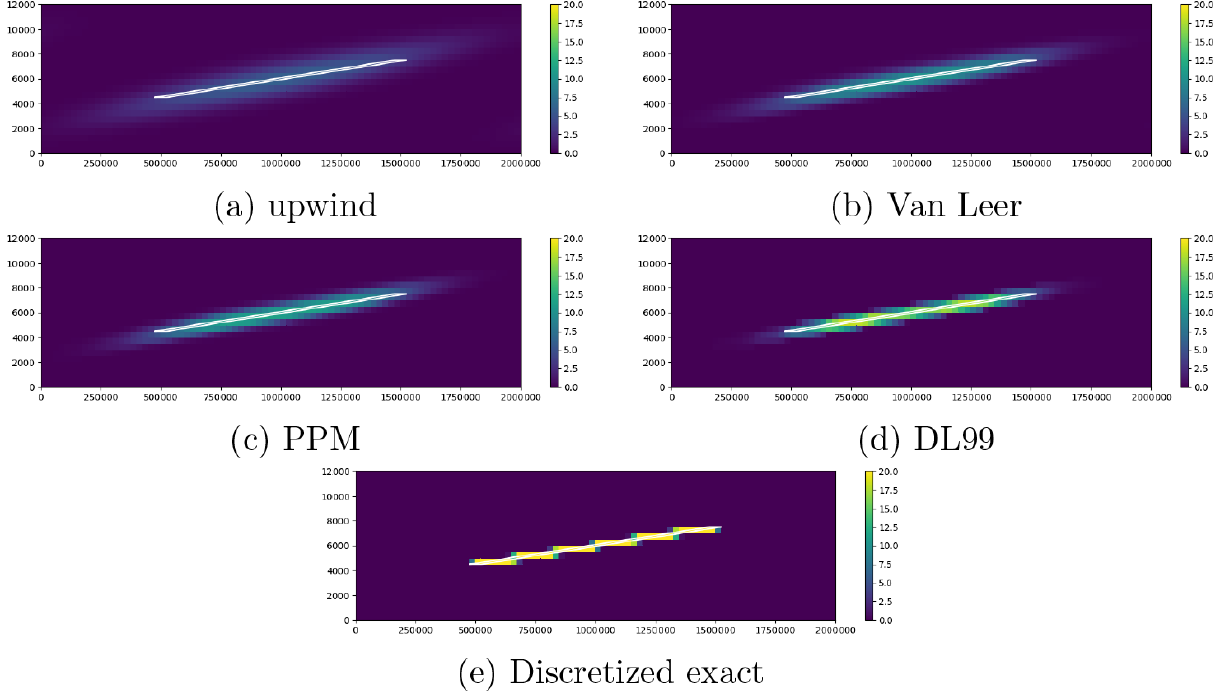
Figure 1. Final state of the numerical simulation for Case 1 after simulations. Panels (a–d) show the results obtained with Upwind, VL, PPM and DL99, respectively, and (e) represents the exact solution discretized on model grid. In (a–e) , the contour of the exact solution is materialized by a white parallelogram.